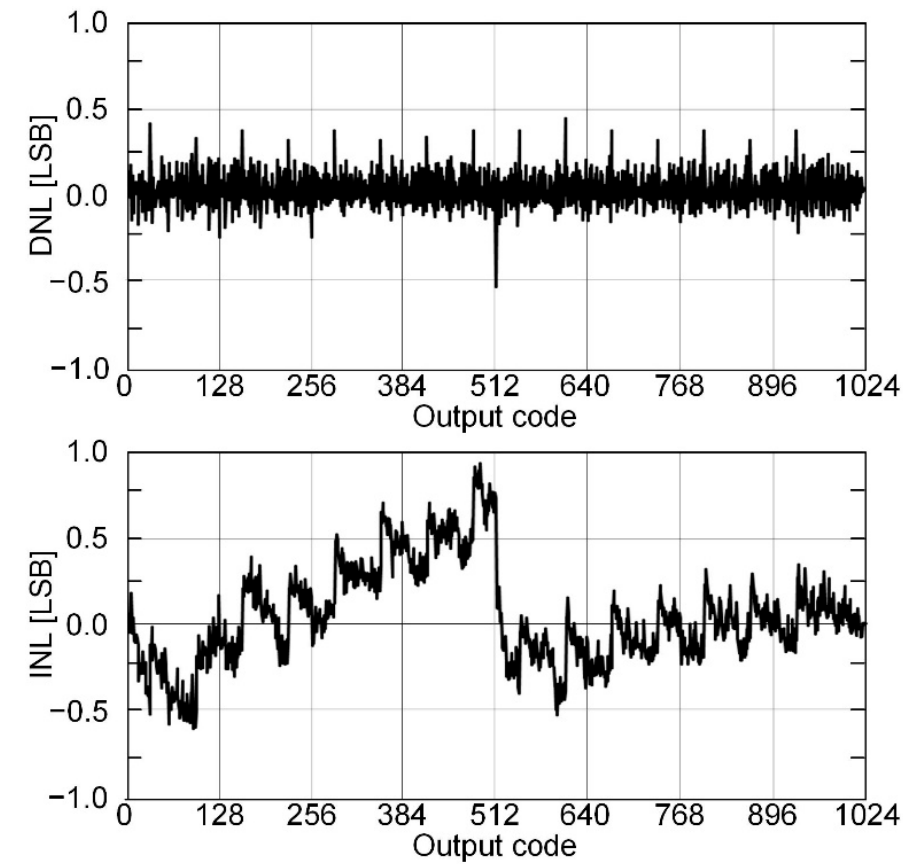
Figure 15. Measured DNL and INL. Table 1. Performance summary and